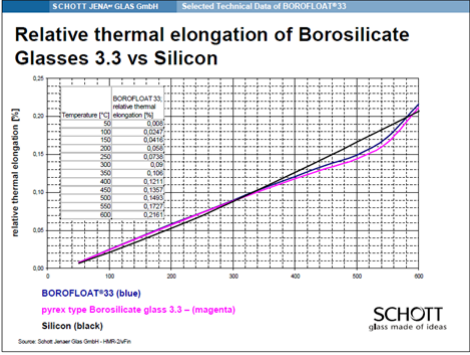
Fig. 3 Thermal elongation as obtained from [Schott,